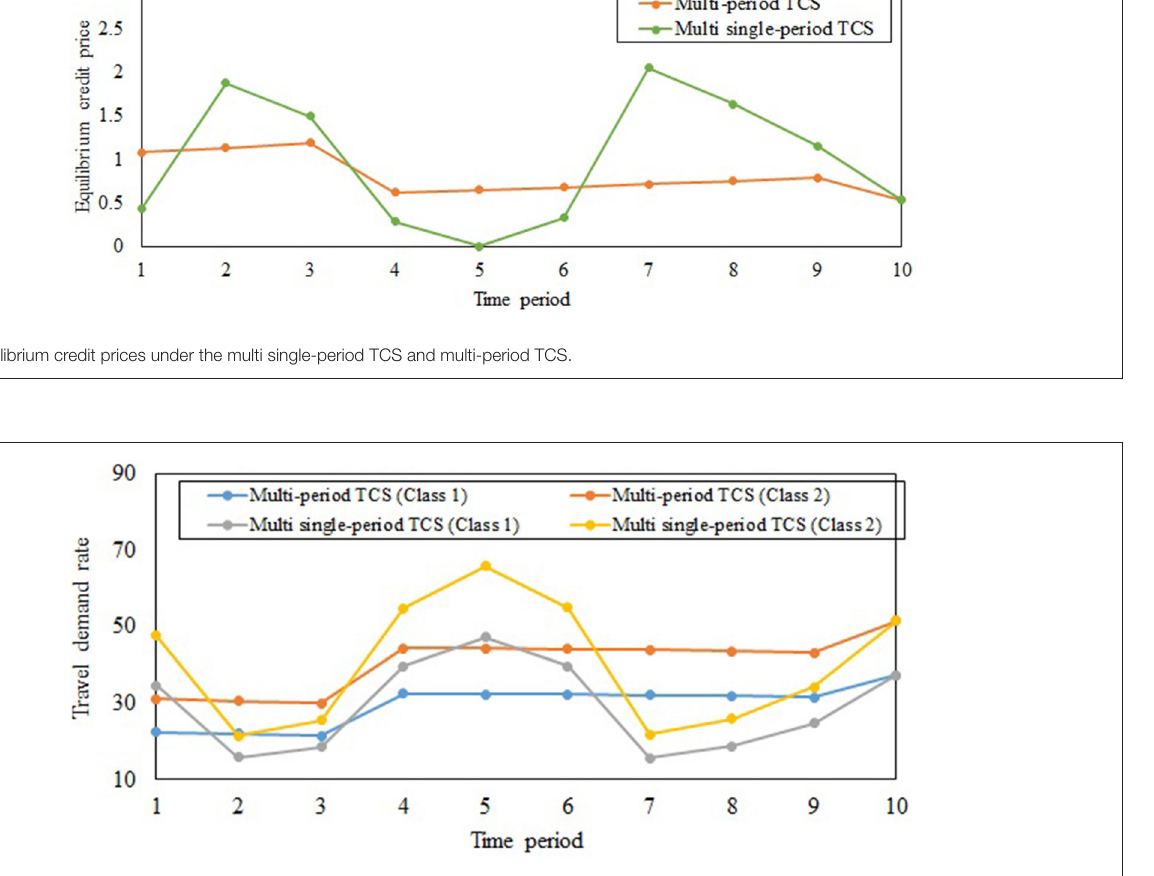
FIGURE 3 | Travel demand rates for the two user classes under the multi-period TCS and the multi single-period TCS.